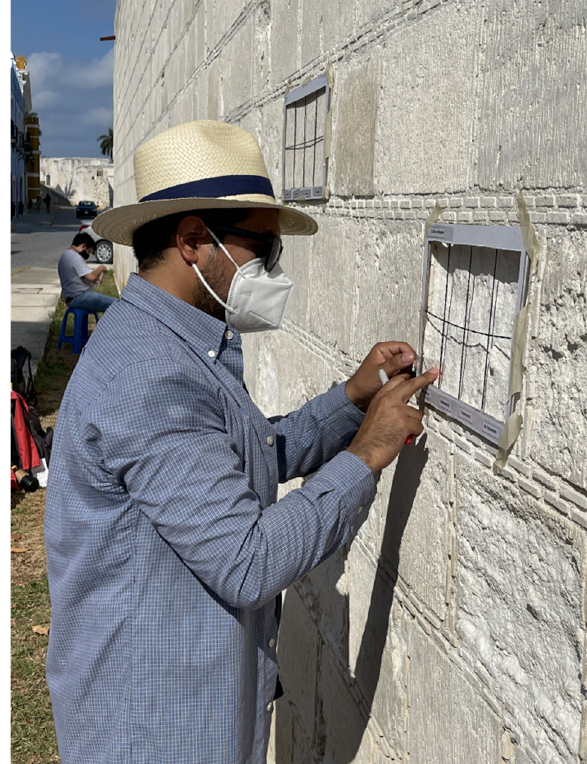
Figure 1. Limestone wall in Campeche, southern México, exhibiting a range of deterioration pathologies. Formers are being used to demarcate panels prior to treatment by spraying with carbonatogenic bacterial suspension or control solution. Replicate panels will allow statistical analysis. The aim is to increase surface hardness and reduce the detachment rate of flaking material.